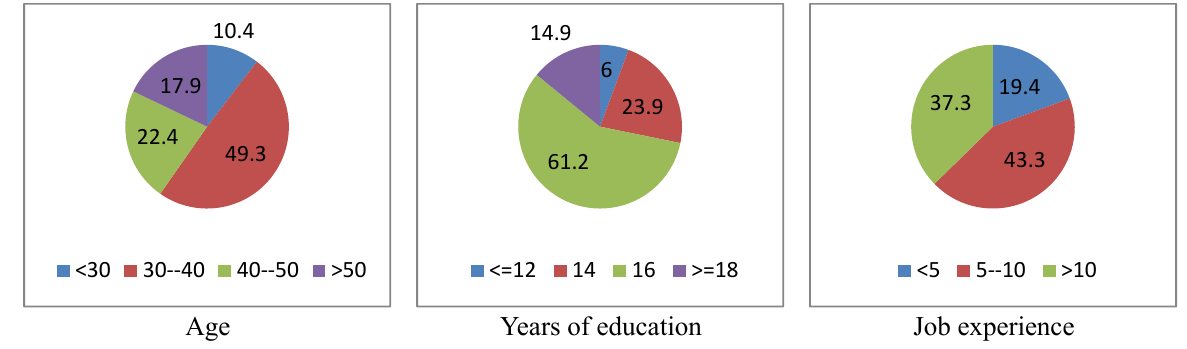
Fig. 2. Personal characteristics of the participants